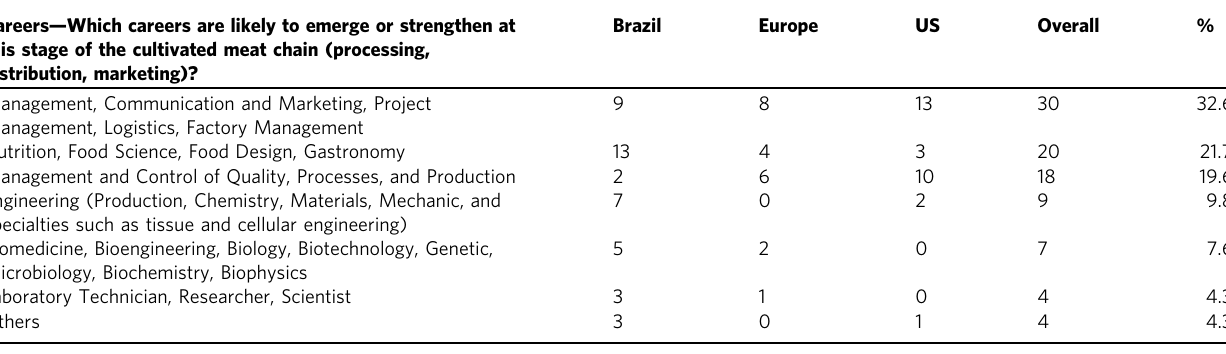
Table 13 Responses regarding the most prominent careers are likely to emerge or strengthen at the third stage of the cultivated meat value chain in Brazil ( N = 21), Europe ( N = 18) and the United States ( N = 17), using an open-ended question.